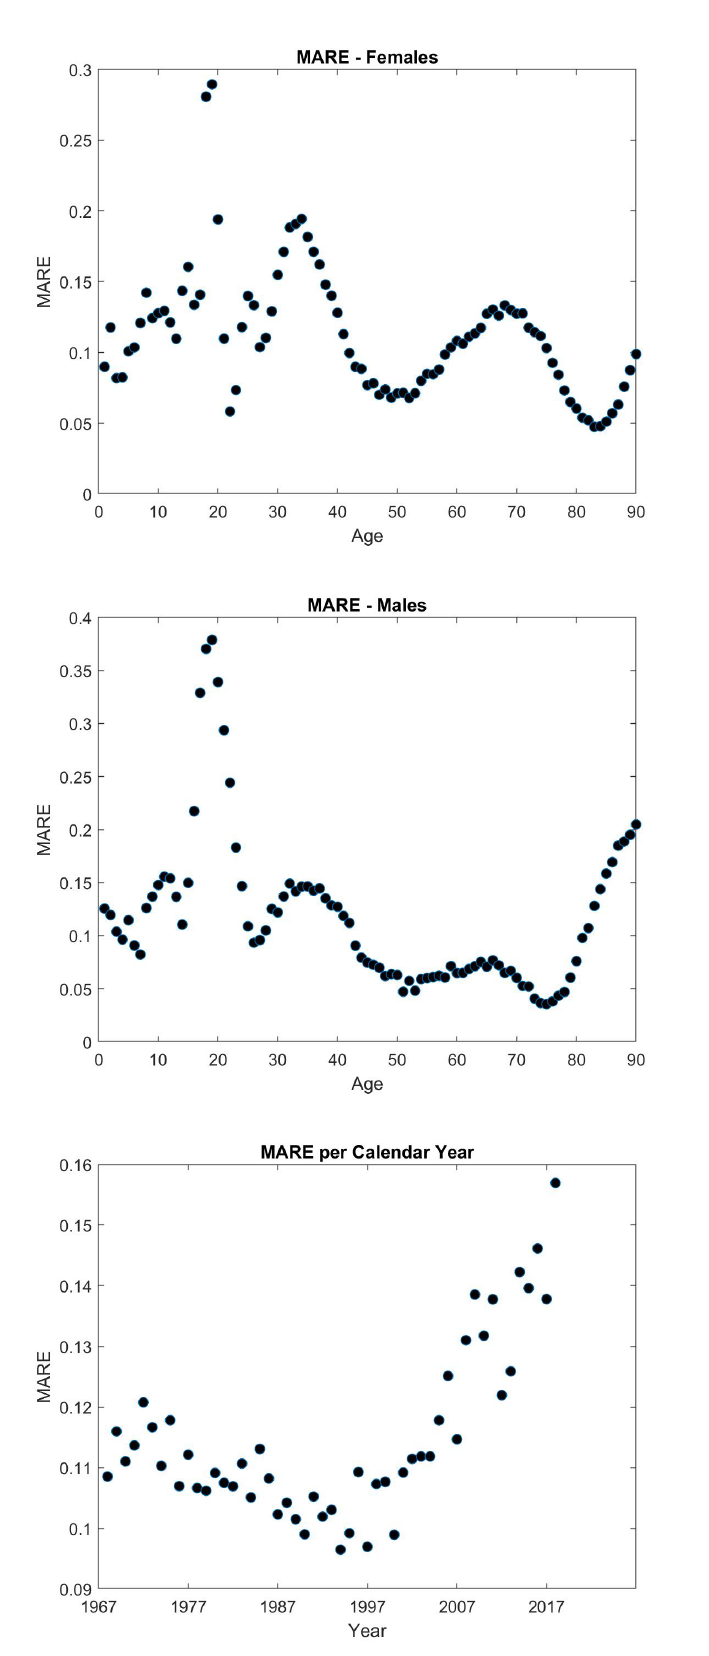
Figure 4. The figure plots the values of the MARE for the ages of female and male participants and averaged over calendar